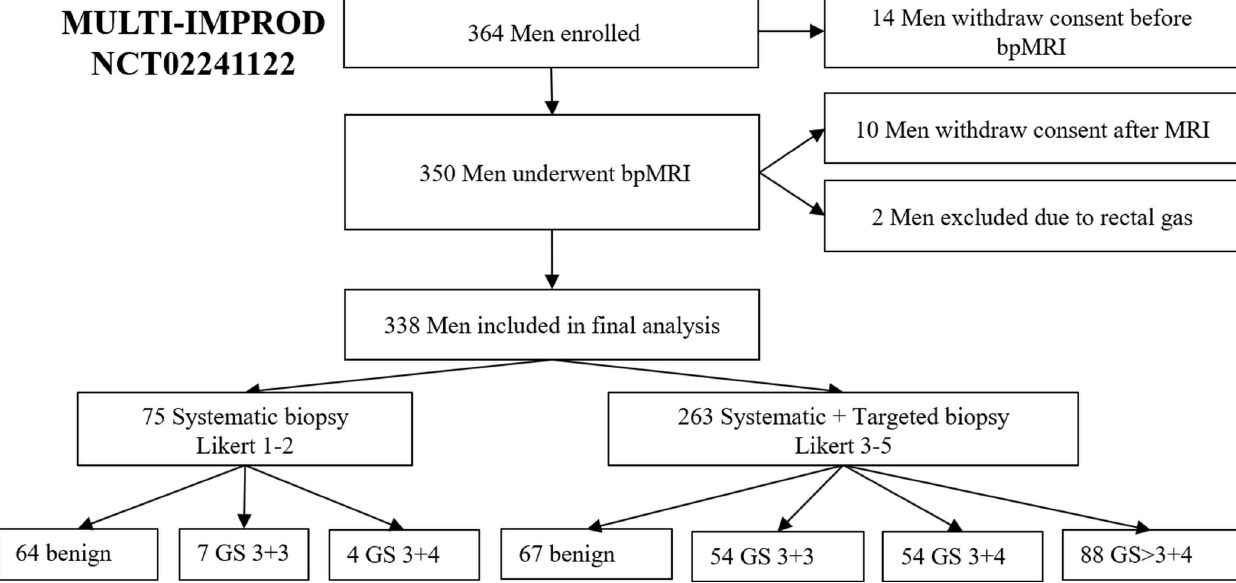
Fig 1. Study flowchart for men undergoing both targeted and systematic biopsy. bpMRI, biparametric magnetic resonance imaging; GS, Gleason score.